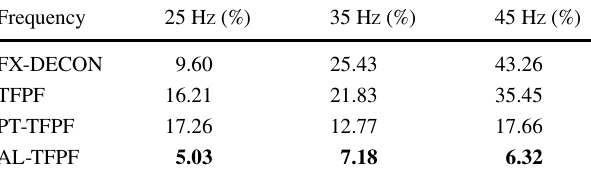
Table 2 SNRs with different